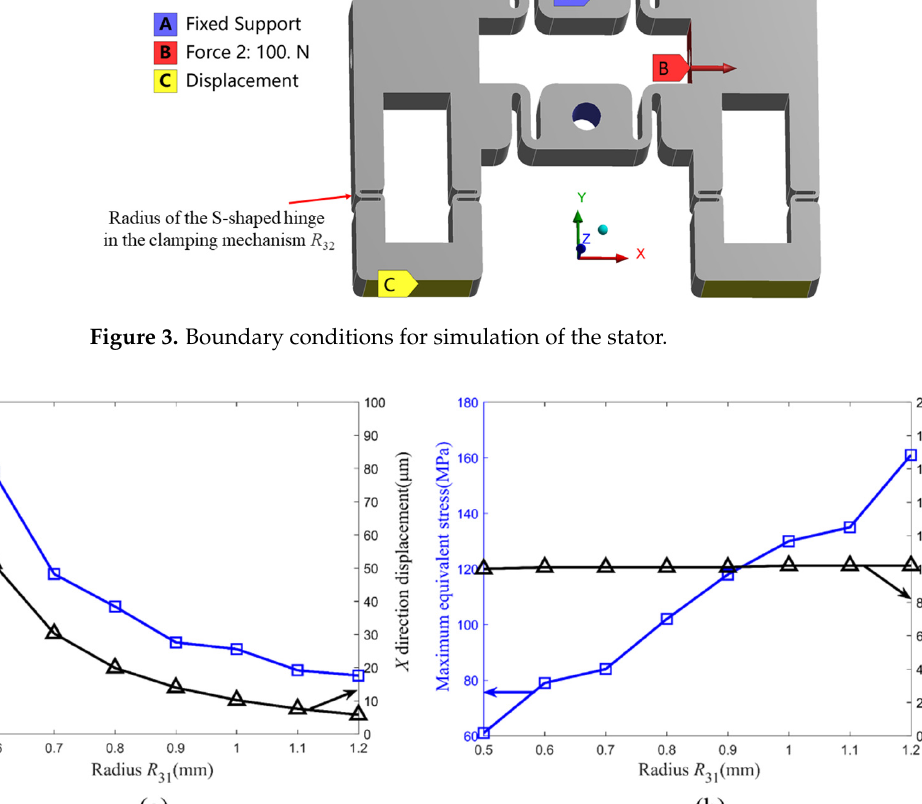
Figure 4. Maximum equivalent stress and output displacement versus radius R 31 under different external loads: ( a ) force of 100 N; ( b ) displacement of 10 μ m.